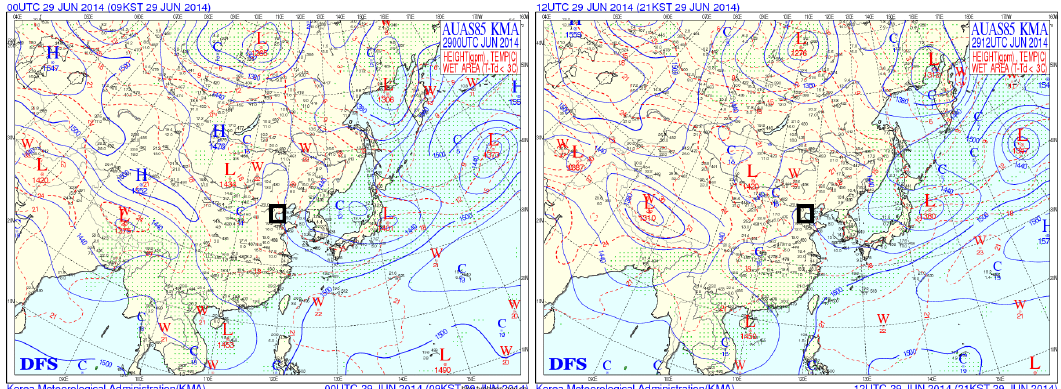
Figure 3. Weather charts at the 850 hPa pressure level on June 29, 2014 (The location of the study area is indicated by the black rectangle. The charts were obtained from the Korean Meteorological Administration).